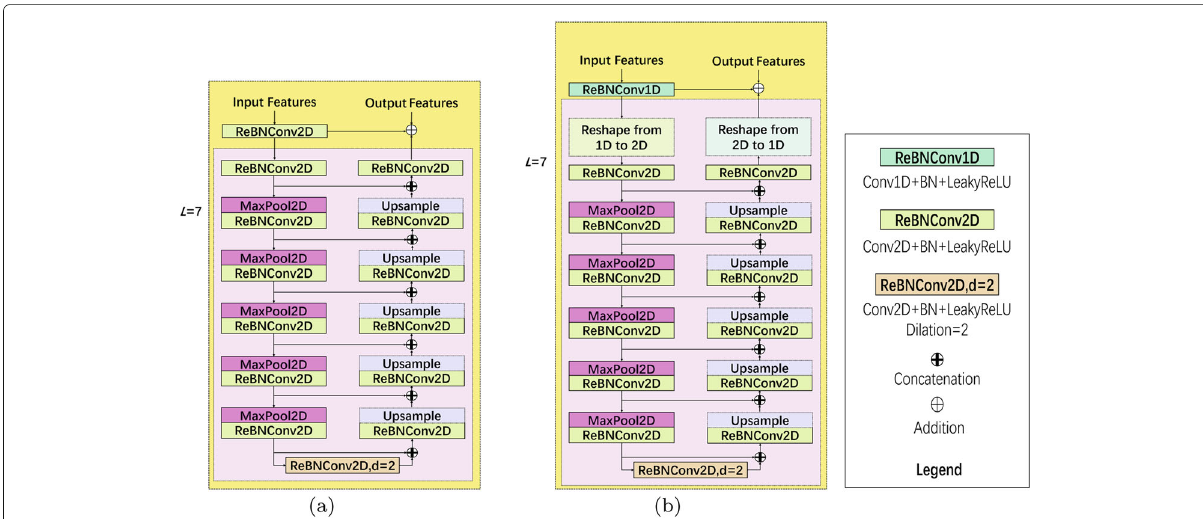
Fig. 2 The comparison of residual U-block (RSU) and 1-2-1 residual U-block (1-2-1 RSU). We set the number of U-block layers ( L ) equal to 7 as an example in both residual U-block and 1-2-1 residual U-block. 1-2-1 RSU with other number of layers have the same structures as 1-2-1 residual U-block ( L